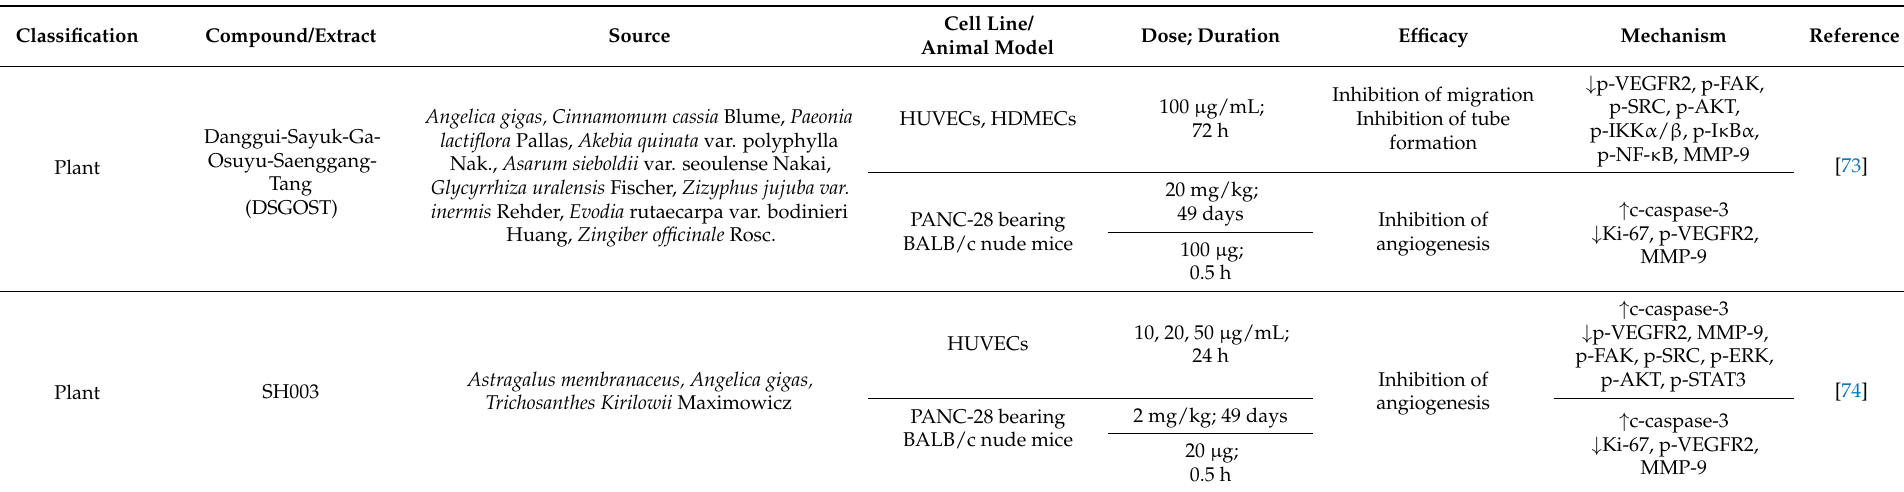
Table 5. Angiogenesis inhibiting natural